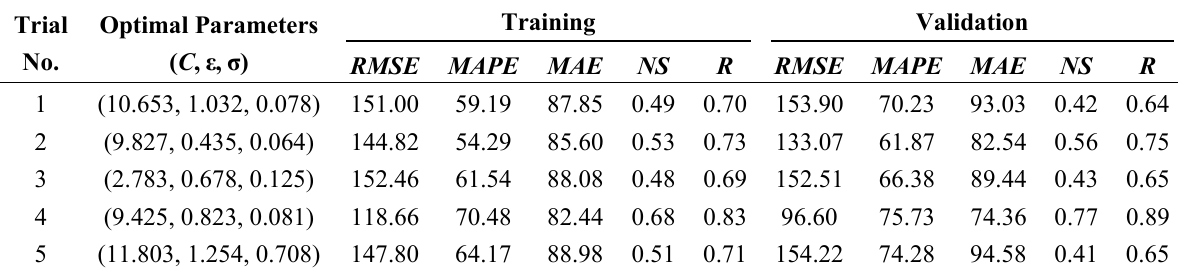
Table 2. The performance statistics of SVM models using GA over five runs.